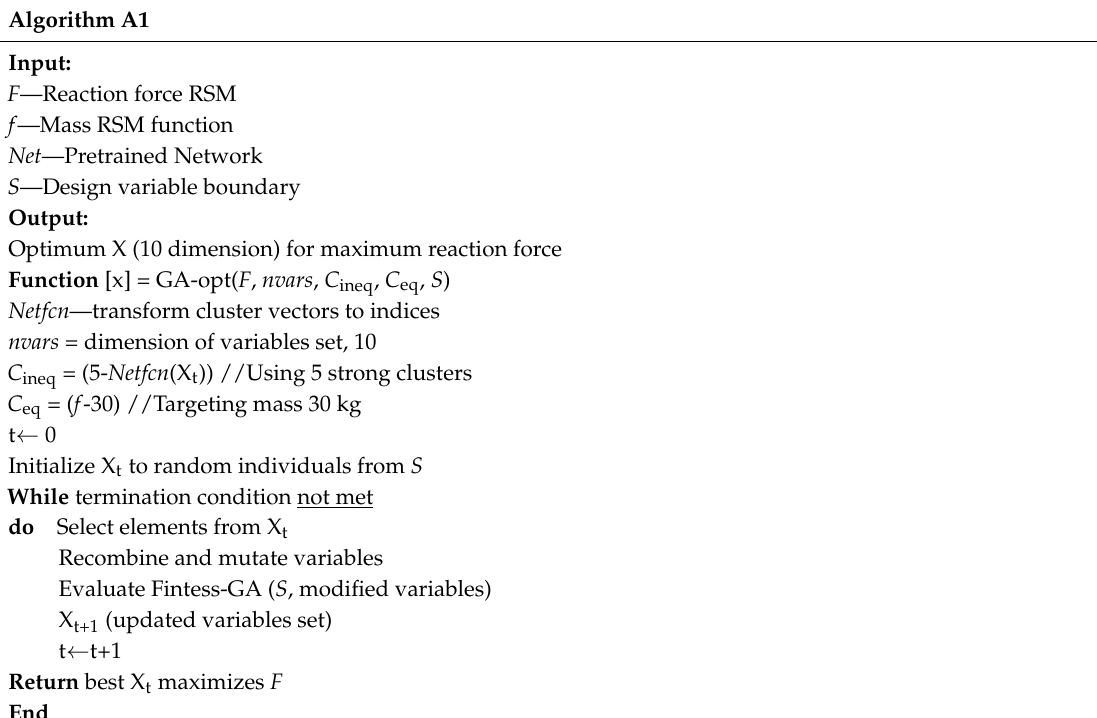
Algorithm A1 : Pseudocode of Optimization Algorithm (Targeting 20 kg and 5 strong clusters from 15